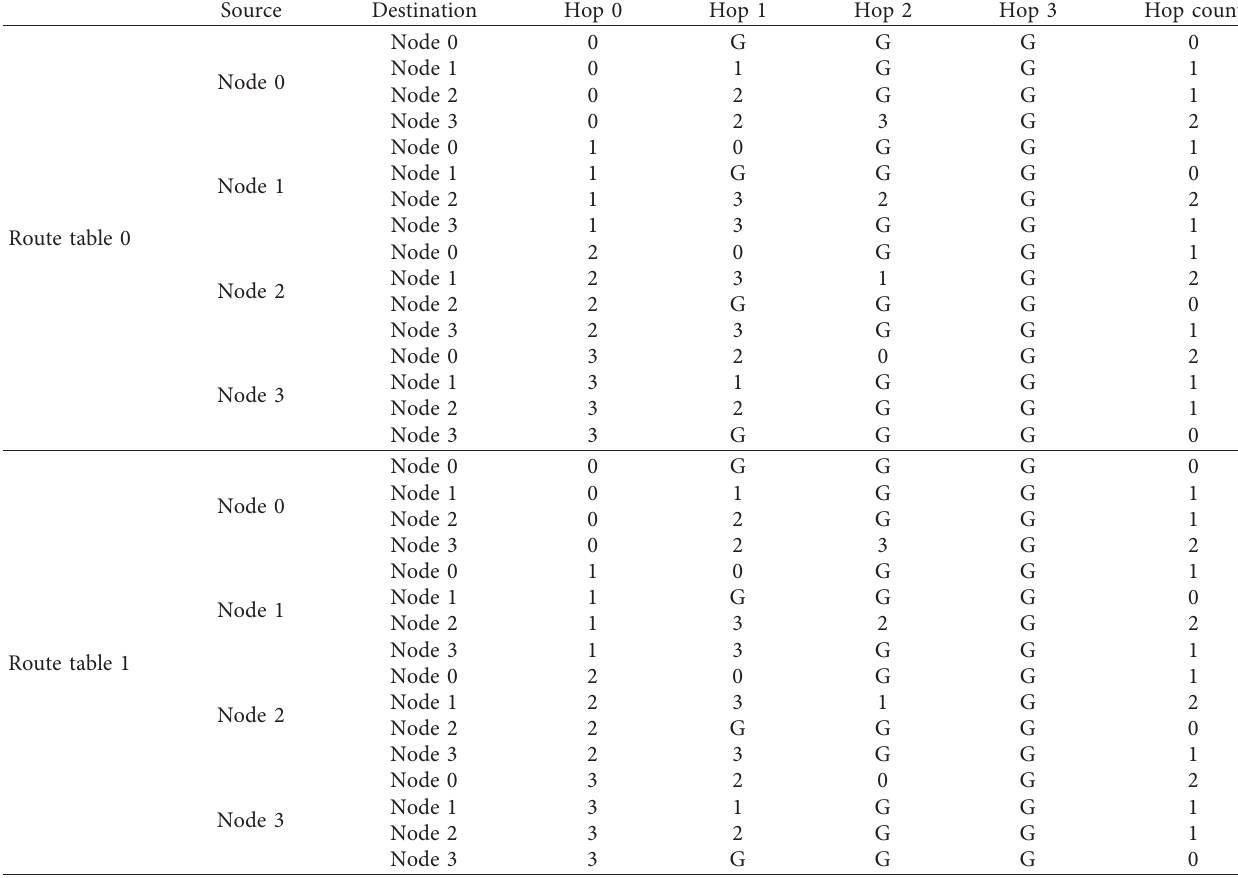
Table 1: Route table of each node.